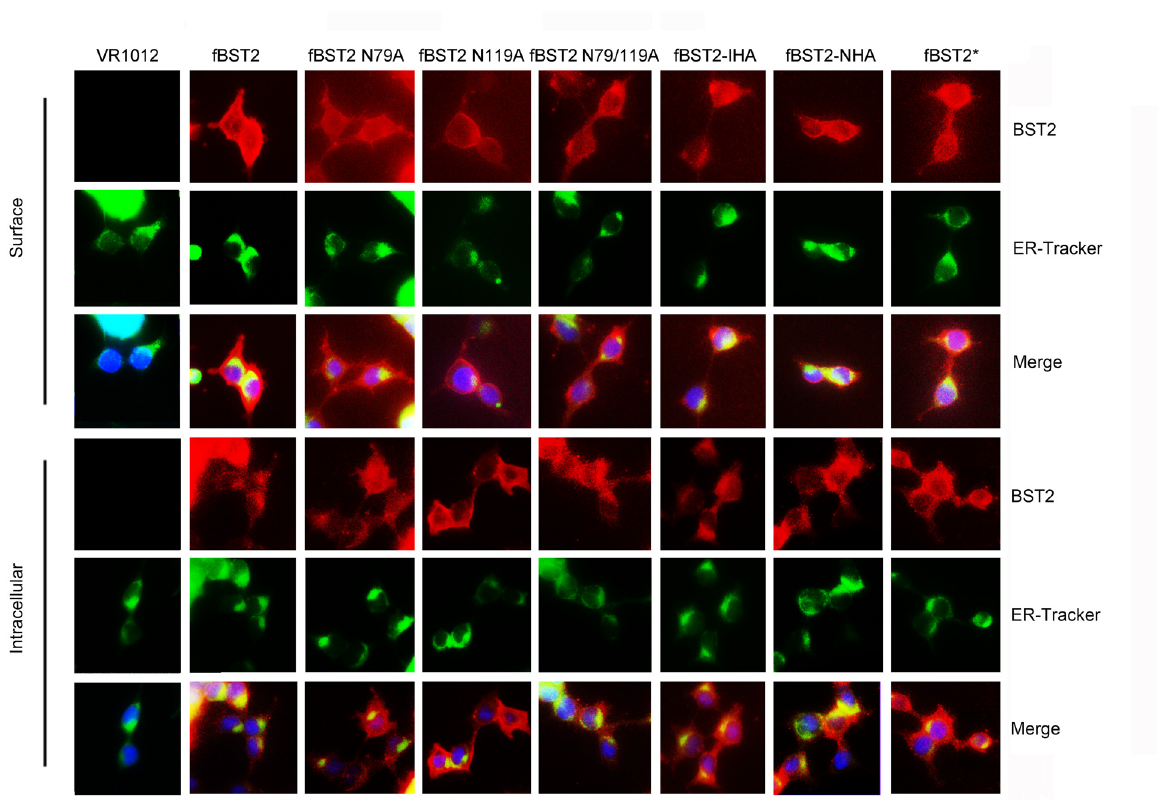
Fig 5. Intracellular localization of BST2 variants. 293T cells transfected with 200 ng of control plasmid VR1012 and expression plasmids fBST2, fBST2 N79A, fBST2 N119A, fBST2 N79/119A, fBST2-IHA, fBST2-NHA and fBST2 * were observed by confocal microscopy with surface staining and intracellular staining: blue, cell nucleus; red, BST2 protein; green, ER. At least 30 independent cells were examined in each sample, and the most representative cells are shown.